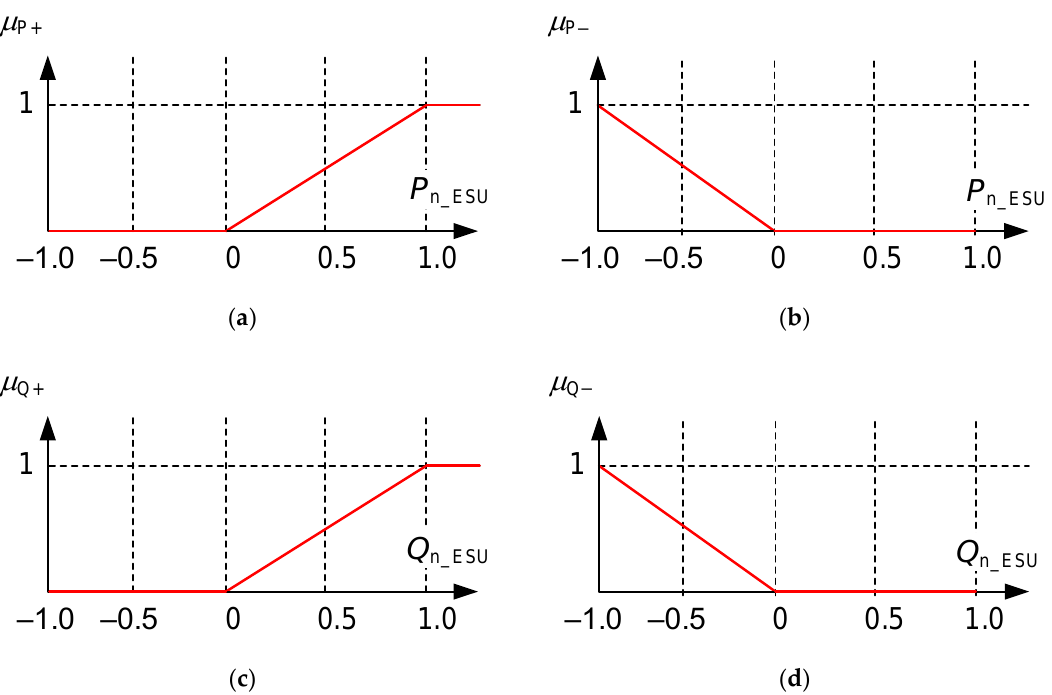
Figure 5. The membership functions for individual output variables: ( a ) to deliver active power to the grid; ( b ) to get active power from the grid; ( c ) to deliver reactive power to the grid; ( d ) to get reactive power from the grid.